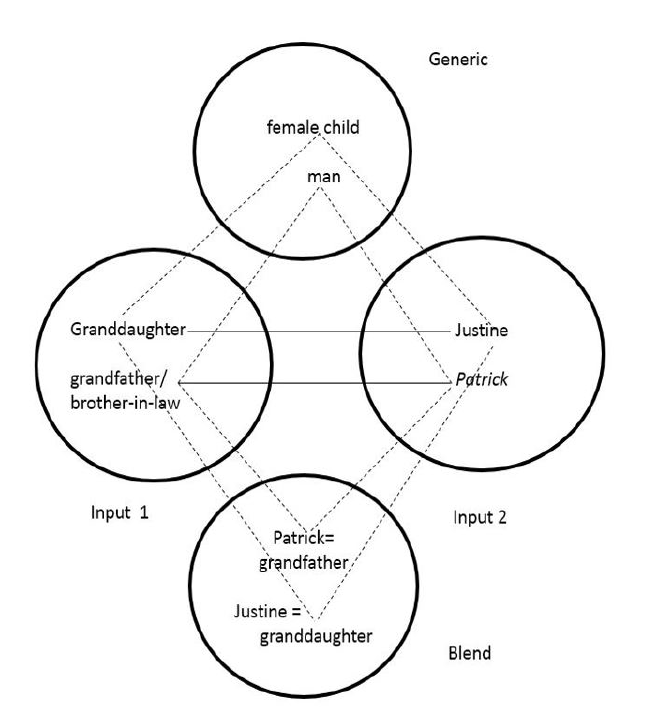
Figure 2: Uncle Patrick‘s granddaughter Patrick is his wife’s second husband, but Justine was born, as Patrick puts it, during his watch and